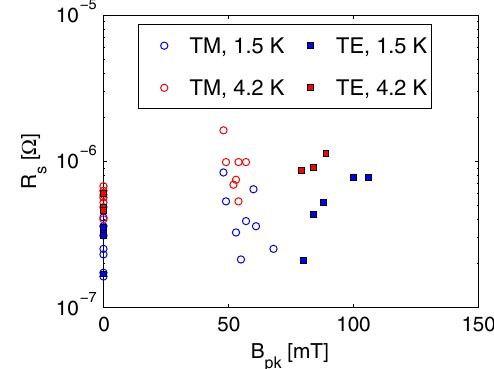
FIG. 1. 1.5 K and 4.2 K data for some of the best Nb 3 Sn TM and TE 10 GHz cavities produced by Siemens AG [14,15]. Only the Q 0 at zero field and at the maximum field were reported. Due to the f 2 dependence of the BCS resistance, R s values here correspond to the n Ω range at ∼ 1 GHz. Fig. 2 [16]. It is a 1.5 GHz single-cell cavity of the CEBAF shape that was tested at Jefferson Lab. Neither field emission nor quench was observed in this measurement; the limitation was available rf power.